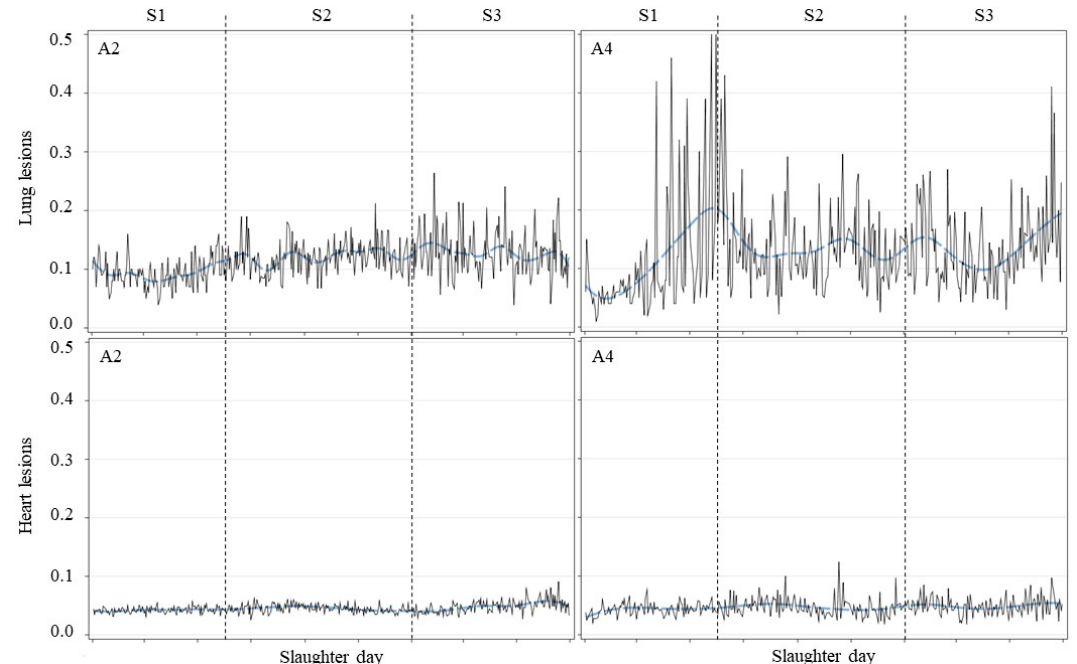
Figure 2. Retransformed random estimates (%) of slaughter day (solid line), nested in abattoir, in the course of six-monthly periods (S1–S3) and the moving average (dashed line); exemplarily illustrated for documented lung and heart lesions of two selected abattoirs (A2 and